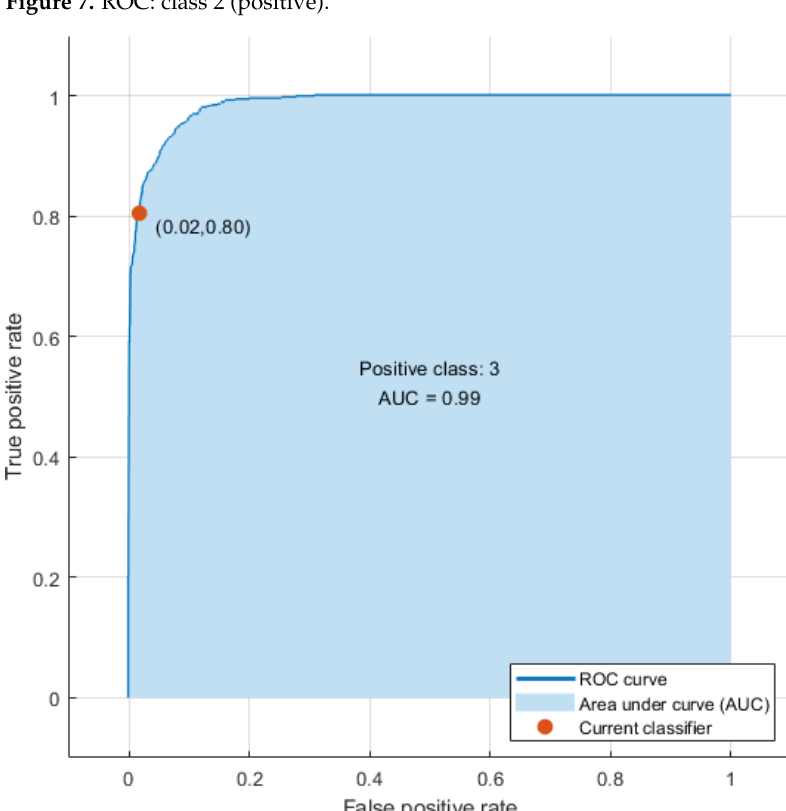
Figure 7. ROC: class 2 (positive).